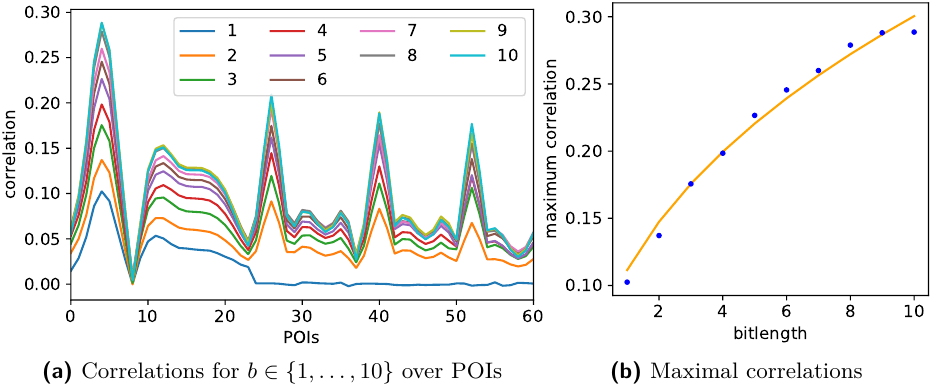
Figure 9: CPOI results on measured traces. Template bit lengths b between 1 and